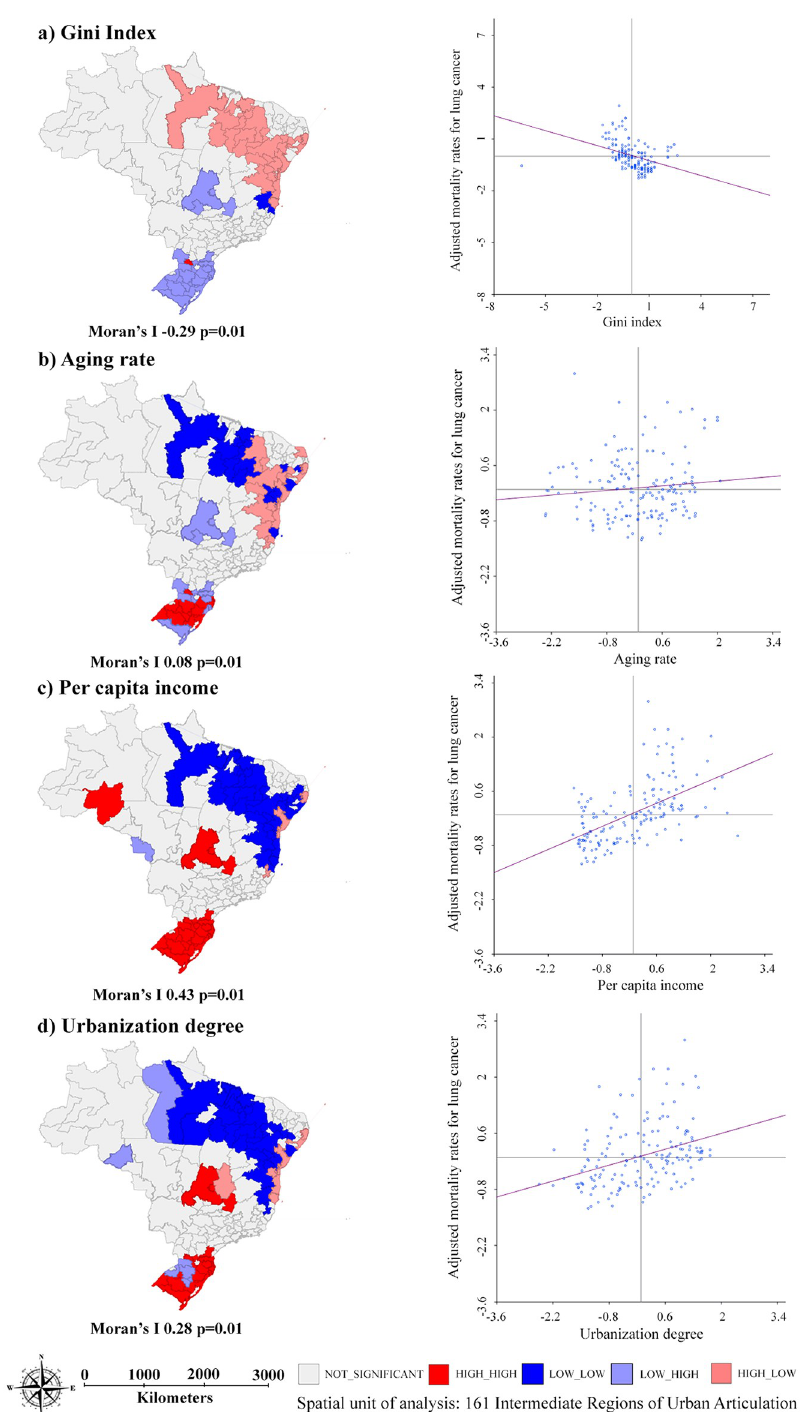
Fig 5. Spatial association between age-adjusted mortality rates for lung cancer, for both sexes, and demographic and socioeconomic indicators per IRUA, Brazil, 2011–2015.